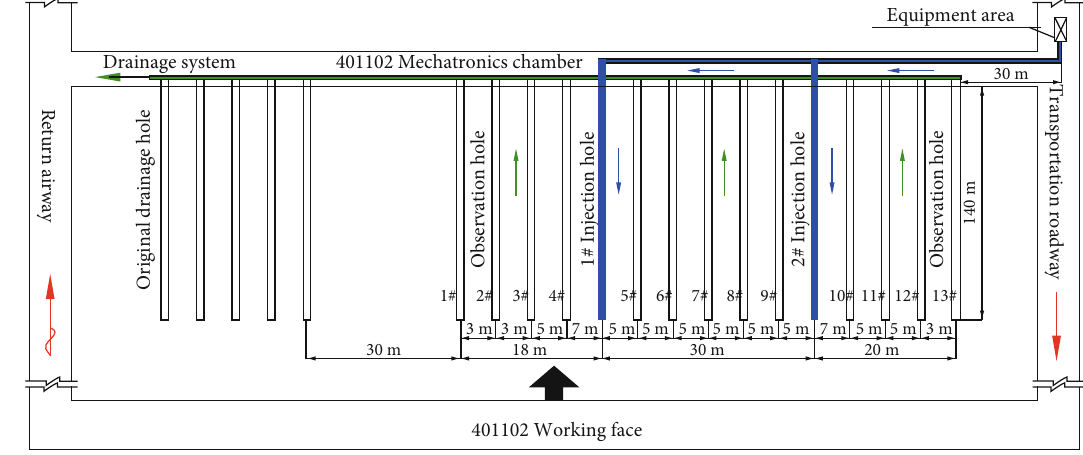
injection system. 2